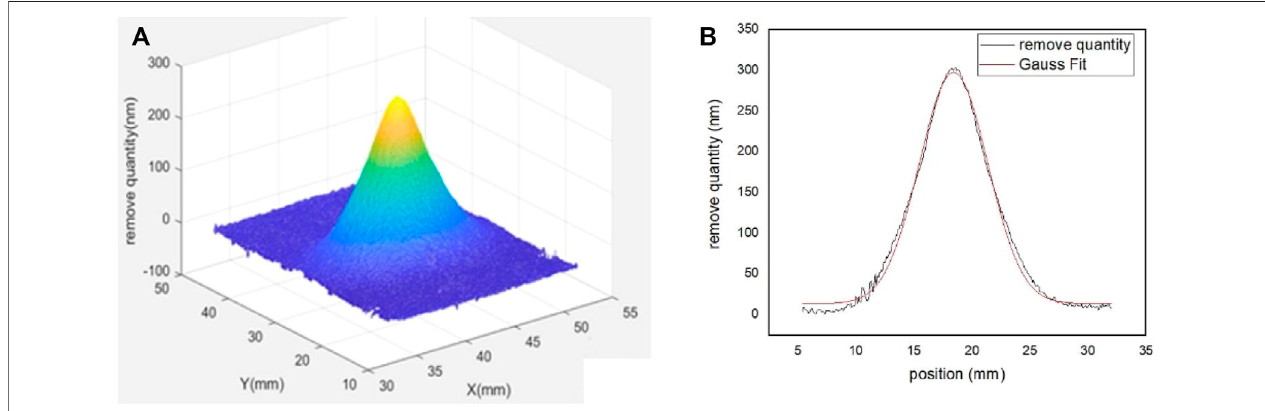
FIGURE 1 | (A) Measured ion beam removal function. (B) One-dimensional pro fi le of the removal function and its Gaussian fi